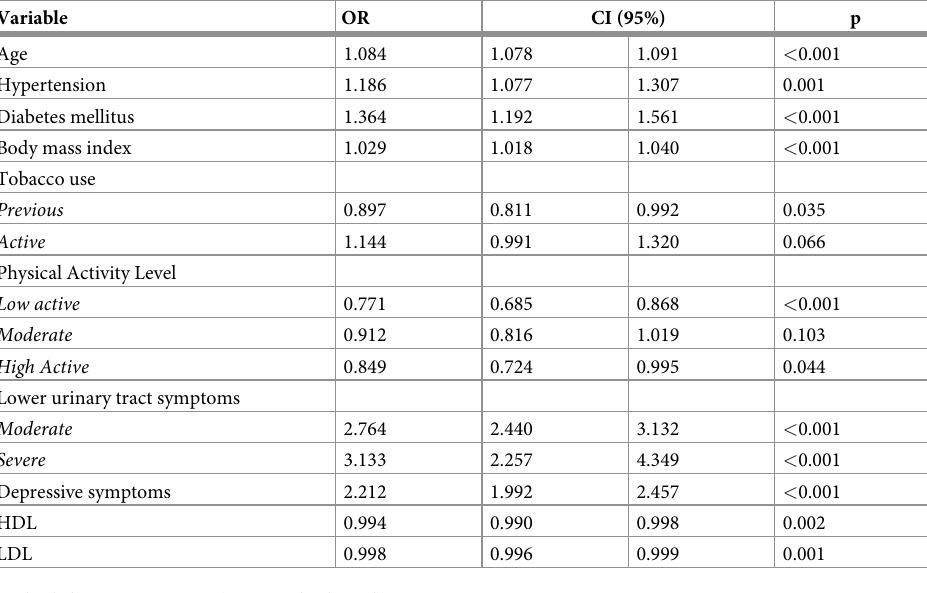
Table 6. Predictors of ED (n =